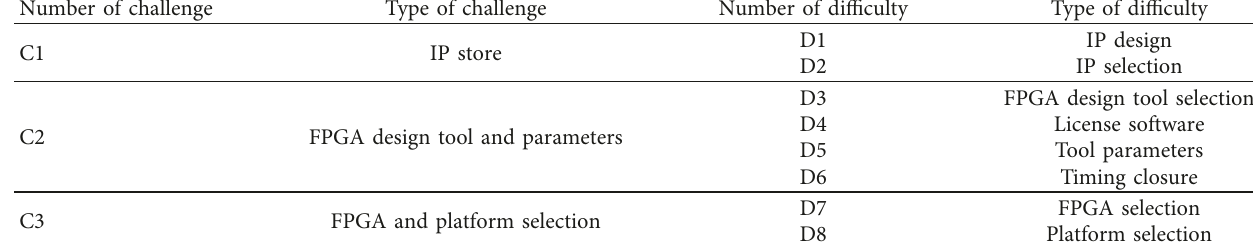
Table 2: Summary of challenges and difficulties of FPGA in Local.